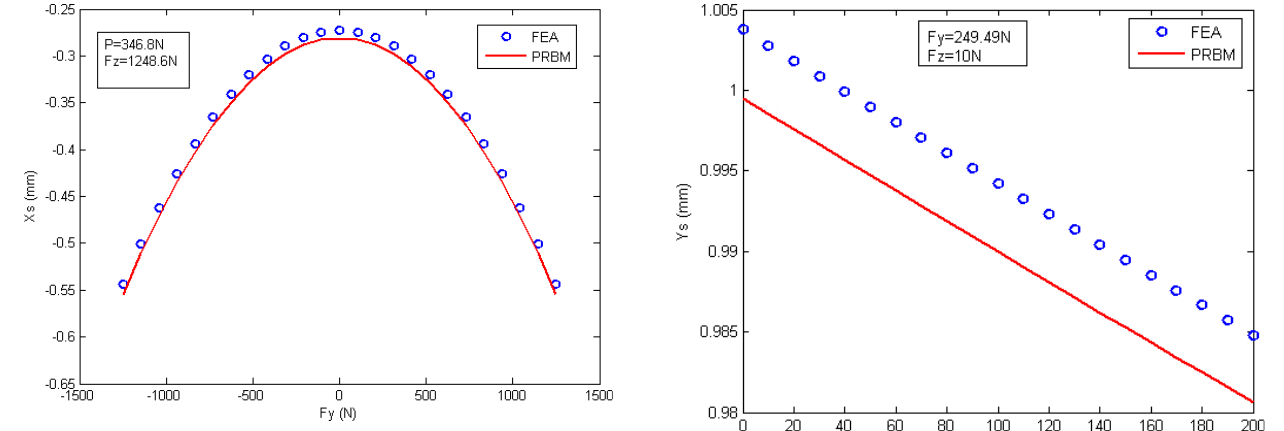
Figure 6. Parasitic translational displacement verification.